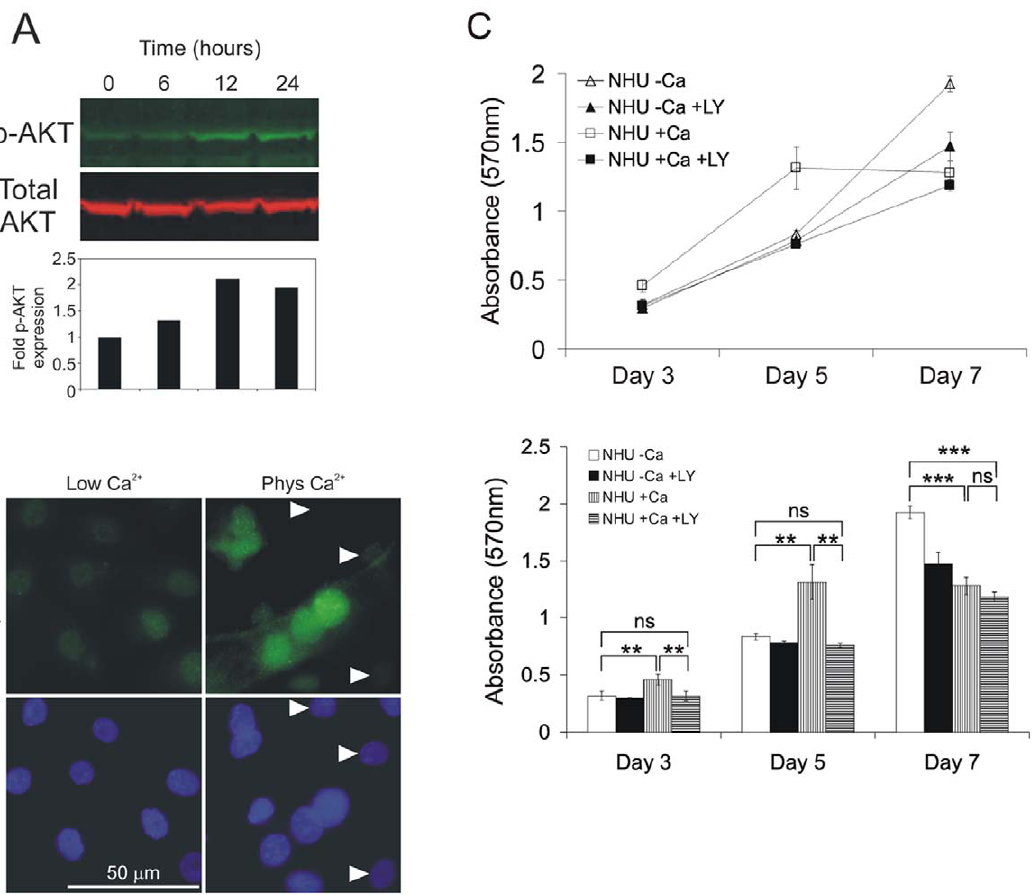
Figure 2. Calcium-induced increase in proliferation in low-density NHU cultures occurs via activation of the PI3-K/AKT pathway. (A) NHU cells were seeded in medium containing low [Ca 2 + ] (0.09 mM) and left to attach overnight. Calcium concentration was then increased to 2 mM and protein lysates were prepared at the indicated time-points for immunoblotting. Expression of phospho-AKT (green) and total AKT (red) was determined using rabbit and mouse antibodies, respectively, followed by fluorochrome-conjugated secondary antisera as in Figure 1C. Immunolabelling was visualised and densitometry to determine fold induction of p-AKT expression with respect to total AKT was performed as in Figure 1C. (B) NHU cells were cultured in medium containing 0.09 mM (Low Ca 2 + ) or 2.0 mM (Phys Ca 2 + ) [Ca 2 + ]. Expression of phospho-AKT (p-AKT) was determined by immunofluorescence microscopy using anti-p-AKT rabbit antibody followed by goat anti-rabbit antibody conjugated with Alexa Fluor 488 (green). Cell nuclei were visualised using Hoechst 33258 (blue). (C) NHU cells were seeded into 96-well plates and cultured for a period of 7 days in medium containing either low (-Ca) or physiological ( + Ca) calcium levels, in the presence or absence of 5 m M of the PI3-K inhibitor LY294002. Proliferation was determined on the basis of cell biomass using the MTT assay. Data points represent mean absorbance values for 6 replicate wells ( 6 S.E.M.). Results for all data points are also presented in the form of bar graphs (lower panel) for the purpose of statistical analysis. ns, non- significant; **, P , 0.01; ***, P ,